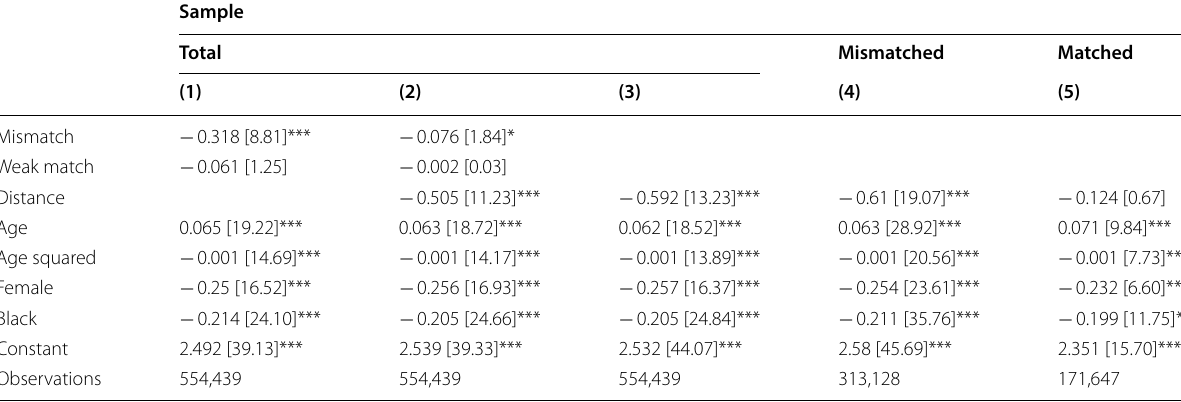
The dependent variable is the logarithm of the hourly labor earnings All regressions include regional dummies and dummies for fields of study Regressions are estimated by OLS and robust t-statistics are in brackets Standard errors are clustered at the occupation-field of study level *, **, ***—indicate significance on the 10%, 5% and 1% level